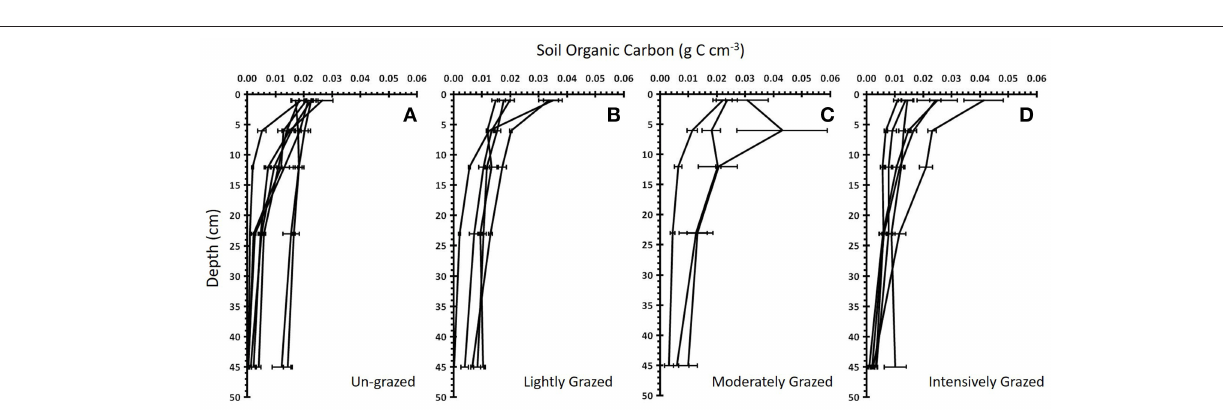
FIGURE 4 | Soil organic carbon with depth for four different grazing intensities. The mean ± standard error soil organic carbon vs. soil depth for each marsh within each “Grazing Intensity” category: (A) un-grazed ( n = 8 marshes), (B) lightly grazed ( n = 5), (C) moderately grazed ( n = 3), and (D) intensively grazed ( n = 6). Each line represents a single